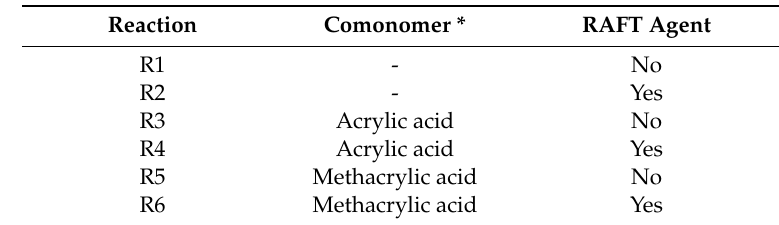
Table 1. Comonomer compositions in the polymerization reactions using methyl methacrylate as the main monomer.